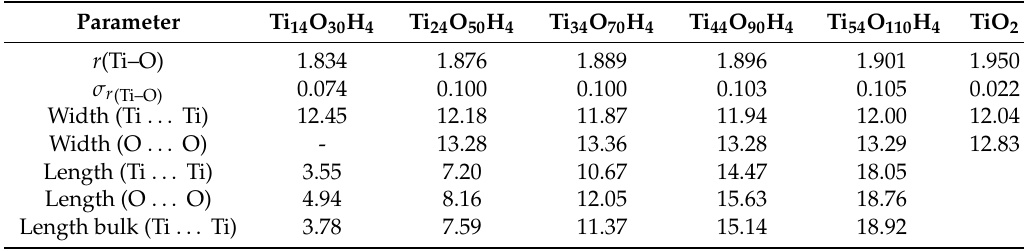
Table 1. Structural parameters describing the optimized geometry of Ti n O 2 n +2 H 4 clusters ( n = 14, 24, 34, 44, 54) performed by DFT at the B3LYP/3-21G(d) level in vacuum. The average Ti–O distance and its standard deviation, and the cluster width and length, defined by the positions of the peripheral Ti or O atoms and determined by calculations are compared to the experimental values of the bulk TiO 2 [72]. All quantities are expressed in